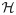
Minimizing reward-sequence prediction errors identifies state abstractions amenable for “deep transfer”.For each task set (A, B, C), all possible state abstractions in H were enumerated using Algorithm U [24] to obtain a ground truth distribution over the hypothesis space H. In each grid-world task (A, C) the agent can transition up, down, left, or right to move to an adjacent grid cell. If the agent attempts to transition of the grid or across one of the black barriers in (C), then the agent remains at its current grid position. State abstractions were scored by compressing an MDP using the state abstraction of interest [6]. The total reward score was computed by running the computed policy 20 times for 10 time steps in the MDP from a randomly selected start state. The reward-sequence error was computed by selecting 20 random start states and then performing a random walk for 10 time steps. (D, E, F) The histograms report averages over all repeats and transfer MDPs for all state abstractions that are possible in a nine state MDP. (G, H, I) The histograms report averages over all repeats and transfer MDPs for all state abstractions that compress nine states into three latent states. For each histogram, the Welch’s t-test was performed to compute the p-values of the difference in mean total reward being insignificant for each histogram.